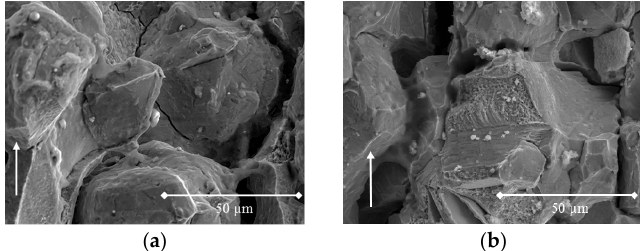
Figure 8. Complex brittle IG and TG fractures of the 5.2 dpa irradiated 18Cr-10Ni-Ti CT specimen if broken to open in nitrogen vapor at about − 100 °C; arrows indicate the crack growth direction: ( a ) one specimen; ( b ) second specimen [3].